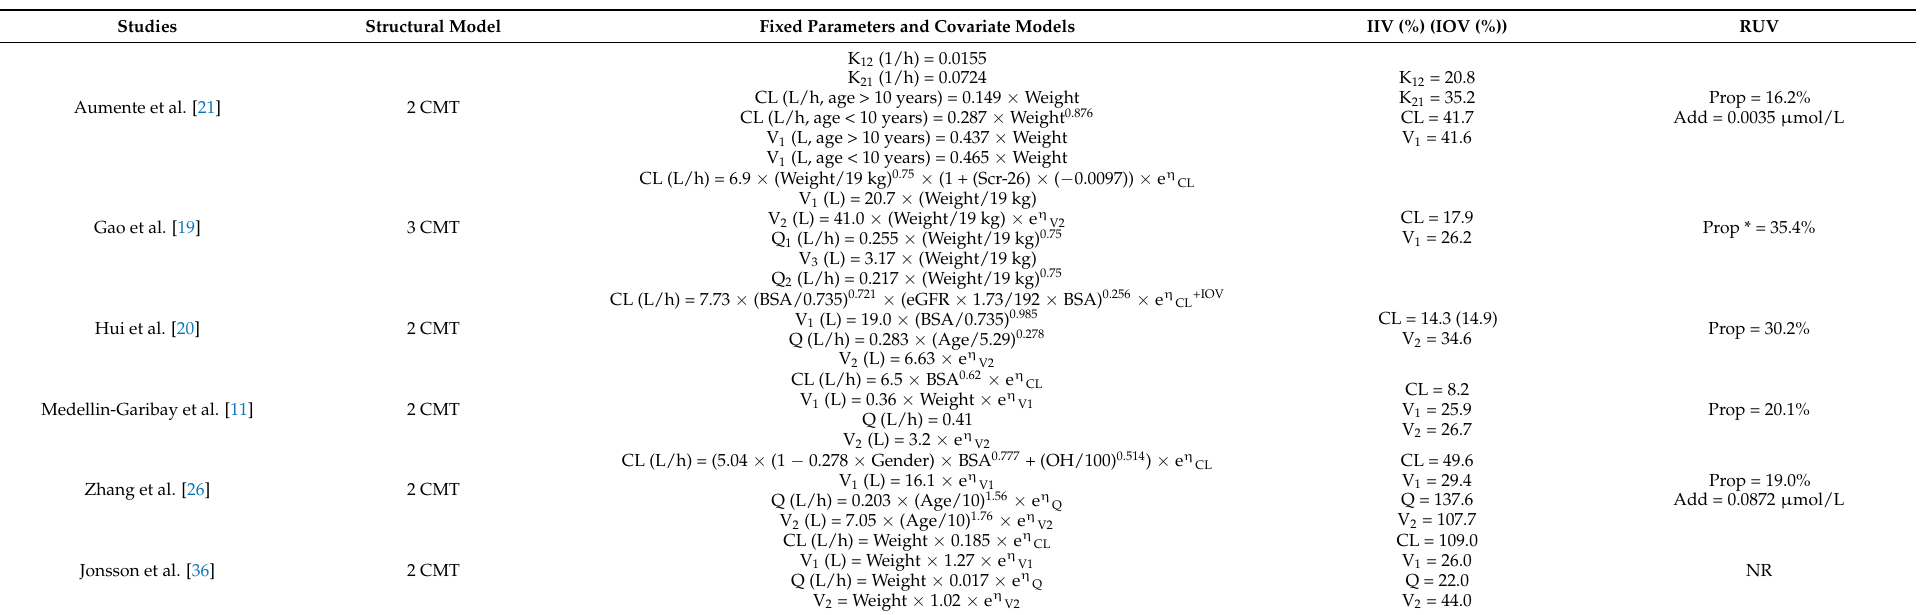
Table 2. Summary of the included population pharmacokinetics model of methotrexate for external